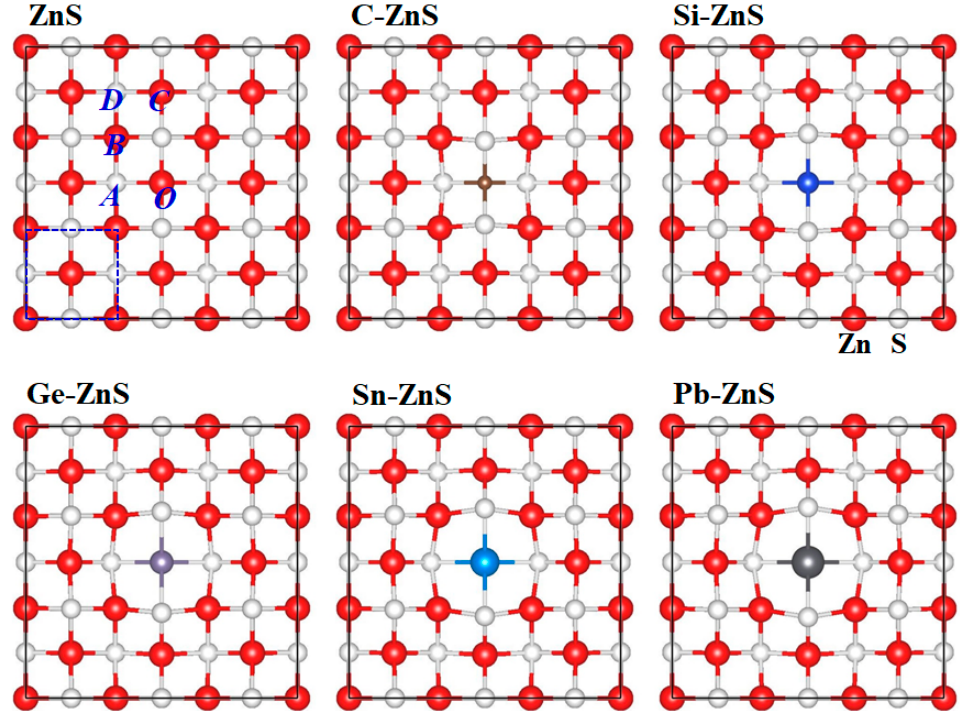
Figure 1. The supercell of the ZnS monolayer and the corresponding doped cases, with red and white balls representing Zn and S atoms, respectively.